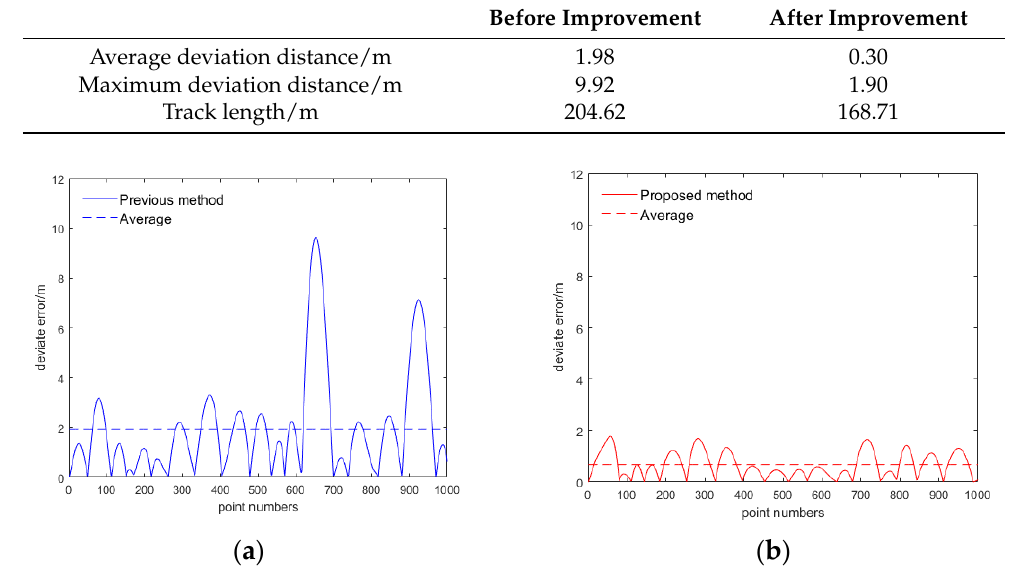
Figure 9. Comparison of UAV trajectory deviation before and after improvement: ( a ) improvements